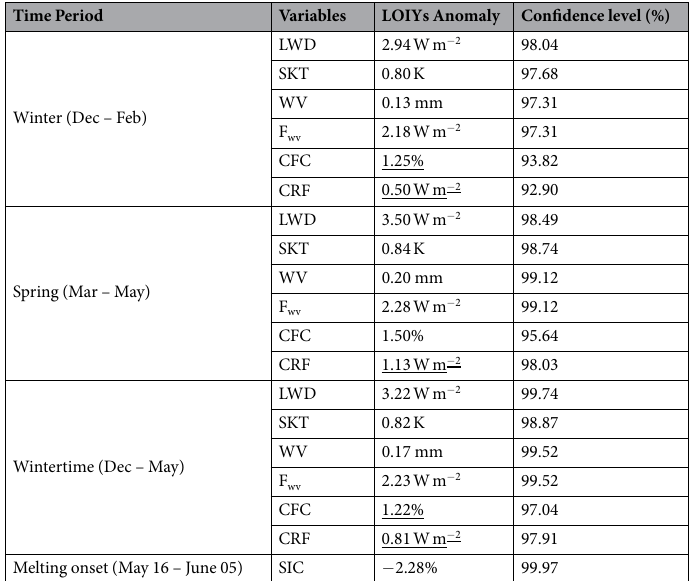
Table 2. Statistical anomalies in surface downward longwave radiation (LWD), skin temperature (SKT), precipitable water vapor (WV), WV radiative forcing (F wv ), cloud fraction (CFC), cloud radiative forcing (CRF) and onset SIC for LOIYs. The confidence level for each variable is based on a Monte Carlo approach with 10,000 iterations, similar to a previous study by 23 . Values marked with underline are the statistical anomalies from 2001 to